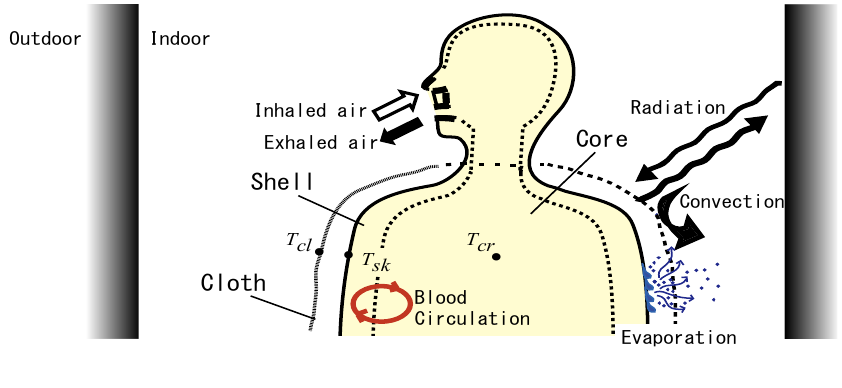
Figure 2. Human body system [1].